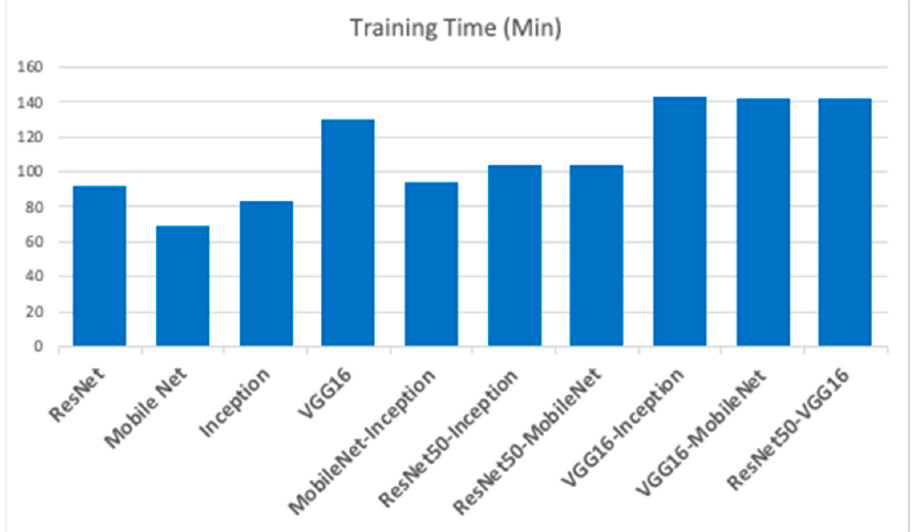
Figure 19. Training Time (Proposed E2DR vs. baseline deep learning models).